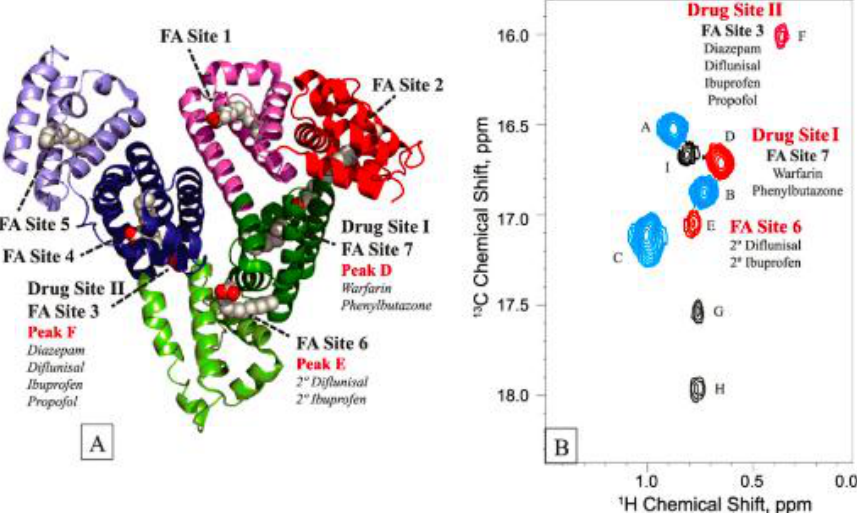
Figure 44. Summary of oleic acid (OA)-HSA competition experiments. ( A ) Crystal of HSA bound to seven labeled OA molecules. Drugs and endogenous compound primary and secondary binding sites are listed (PDB entry 1E7G). ( B ) 1 H- 13 C HSQC spectrum of the 4:1 OA–HSA complex. FA-2, -4, and